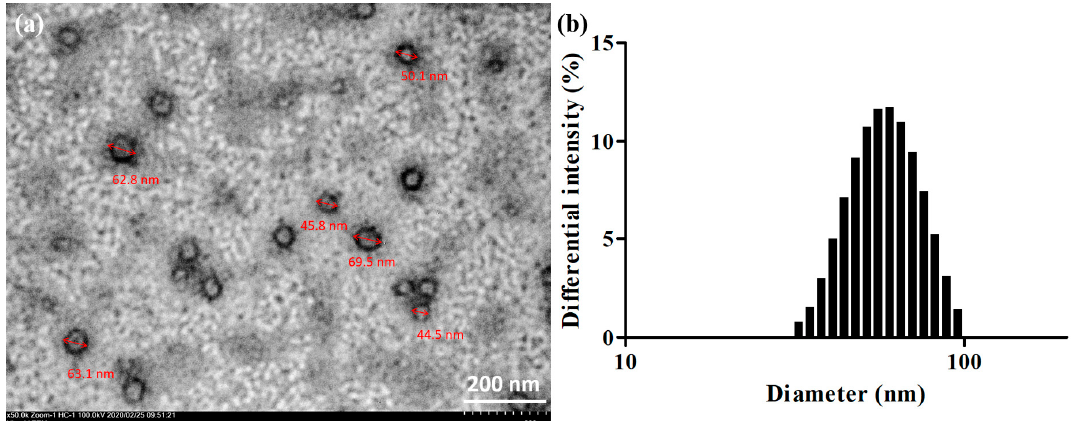
Figure 3. Characterization of F10 morphological observation and droplet sizing: ( a ) The transmission electron microscopy micrographs and ( b ) droplet size distribution.